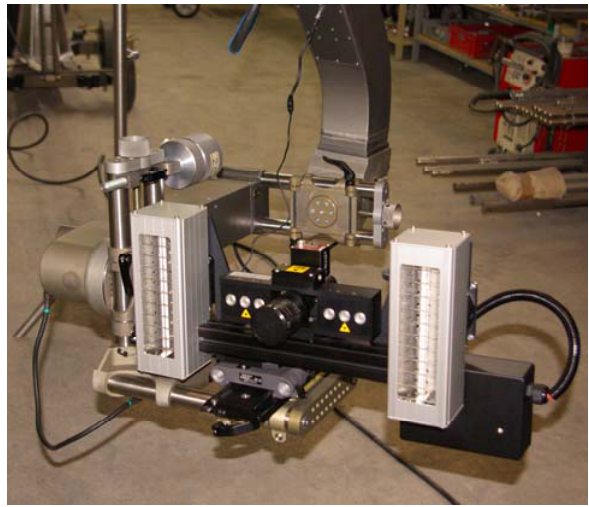
Picture 4. ISIS on the gyroscope ©by G.Gresik